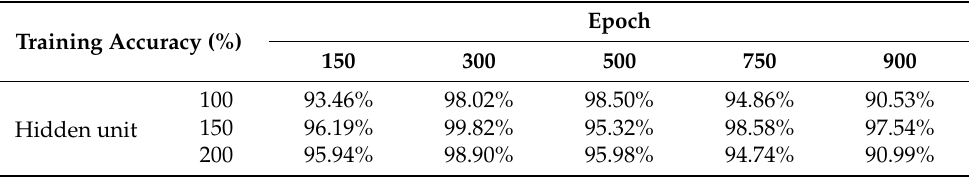
Table 2. Training accuracy according to numbers of epochs and hidden